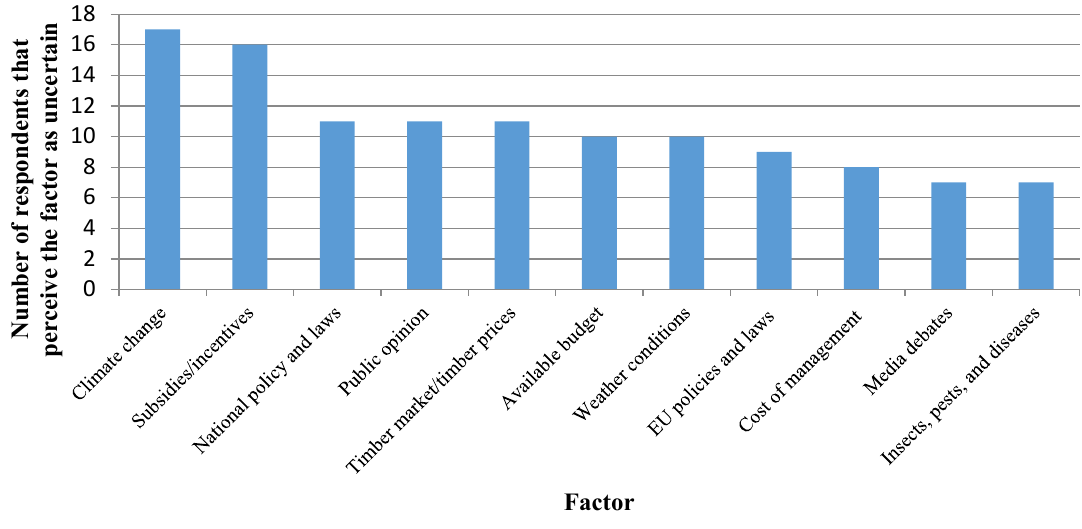
Figure 6. Factors perceived as uncertain by the respondents (only those factors are listed that were mentioned by more than five respondents) ( N =